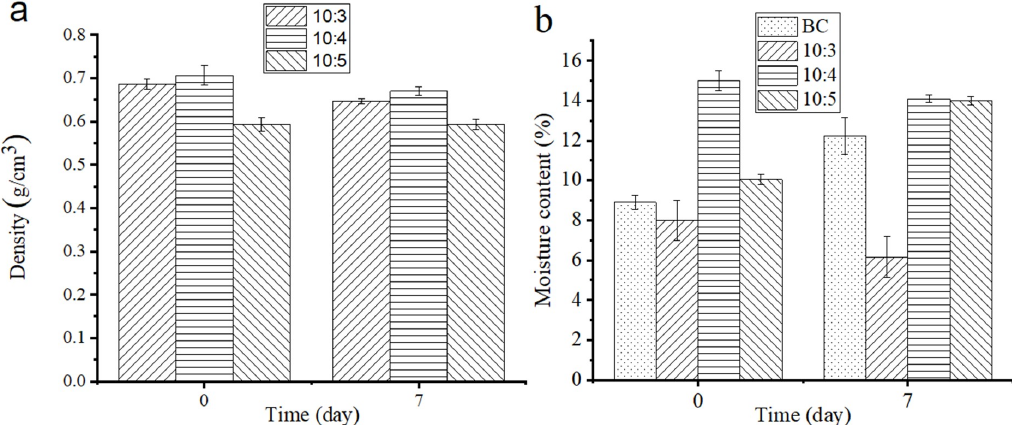
Figure 6. ( a ) Densities and ( b ) moisture content of the BC/SS composites with different mass